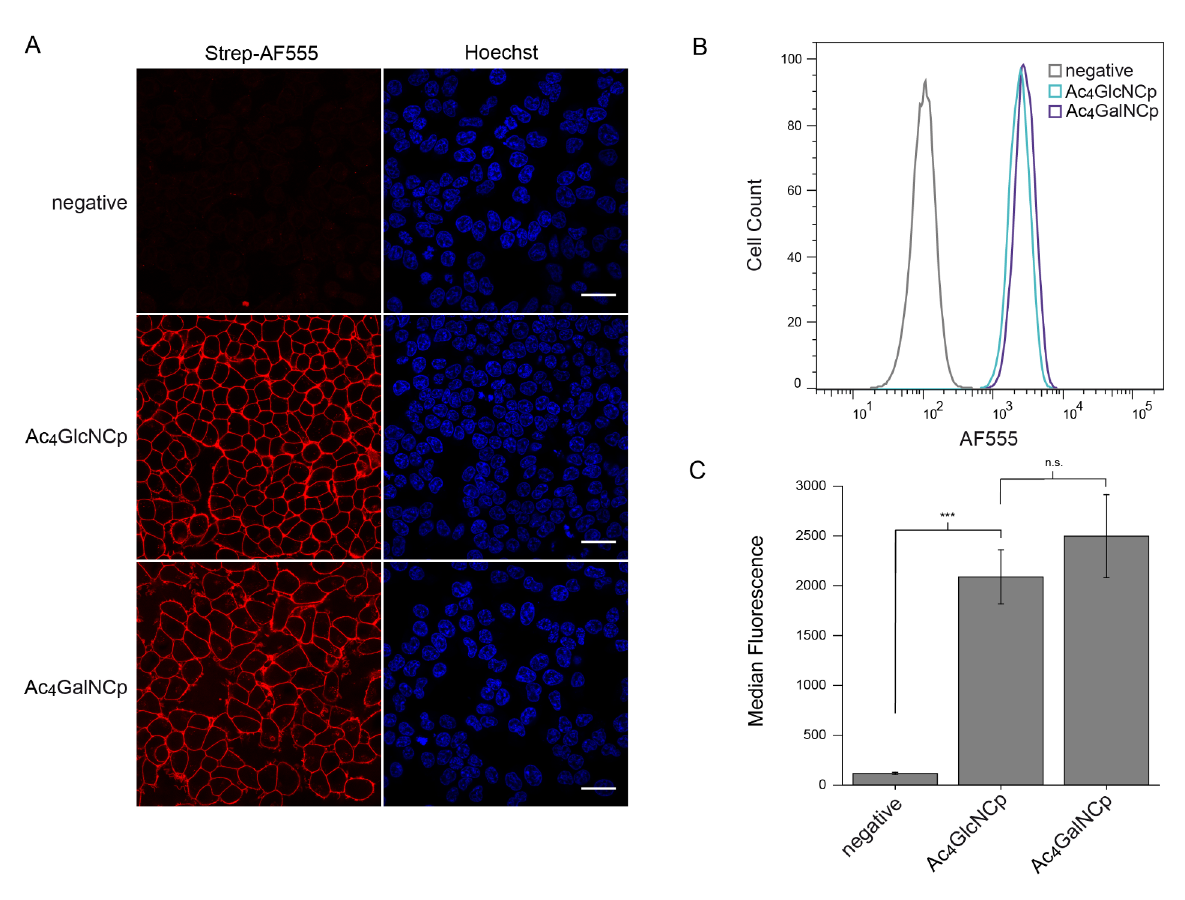
Figure 5: HEK 293T cells were grown with 100 μ M Ac 4 GlcNCp, Ac 4 GalNCp or DMSO only (negative control) for 48 h. Cells were incubated with Tz-biotin (500 μ M) for 3 h (A) or 1 h (B/C) at 37 °C followed by incubation with strep-AF555. A) Results from confocal fluorescence microscopy. Nuclei were stained with Hoechst 33342. Scale bar: 30 μ m. B) Histogram from flow cytometry experiments. C) Median fluorescence from three independent flow cytometry experiments.